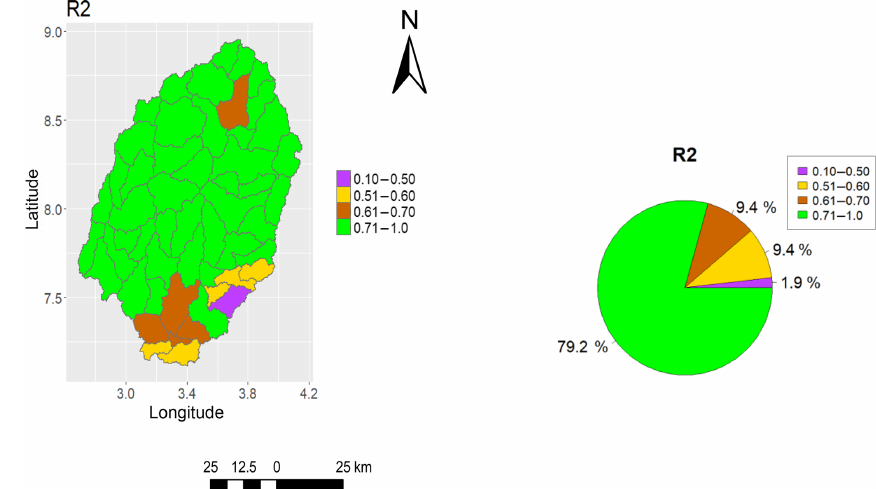
Figure 13. Performance metric ( R 2 ) of SWAT-simulated soil moisture when validated with ESA CCI soil moisture v3.2.